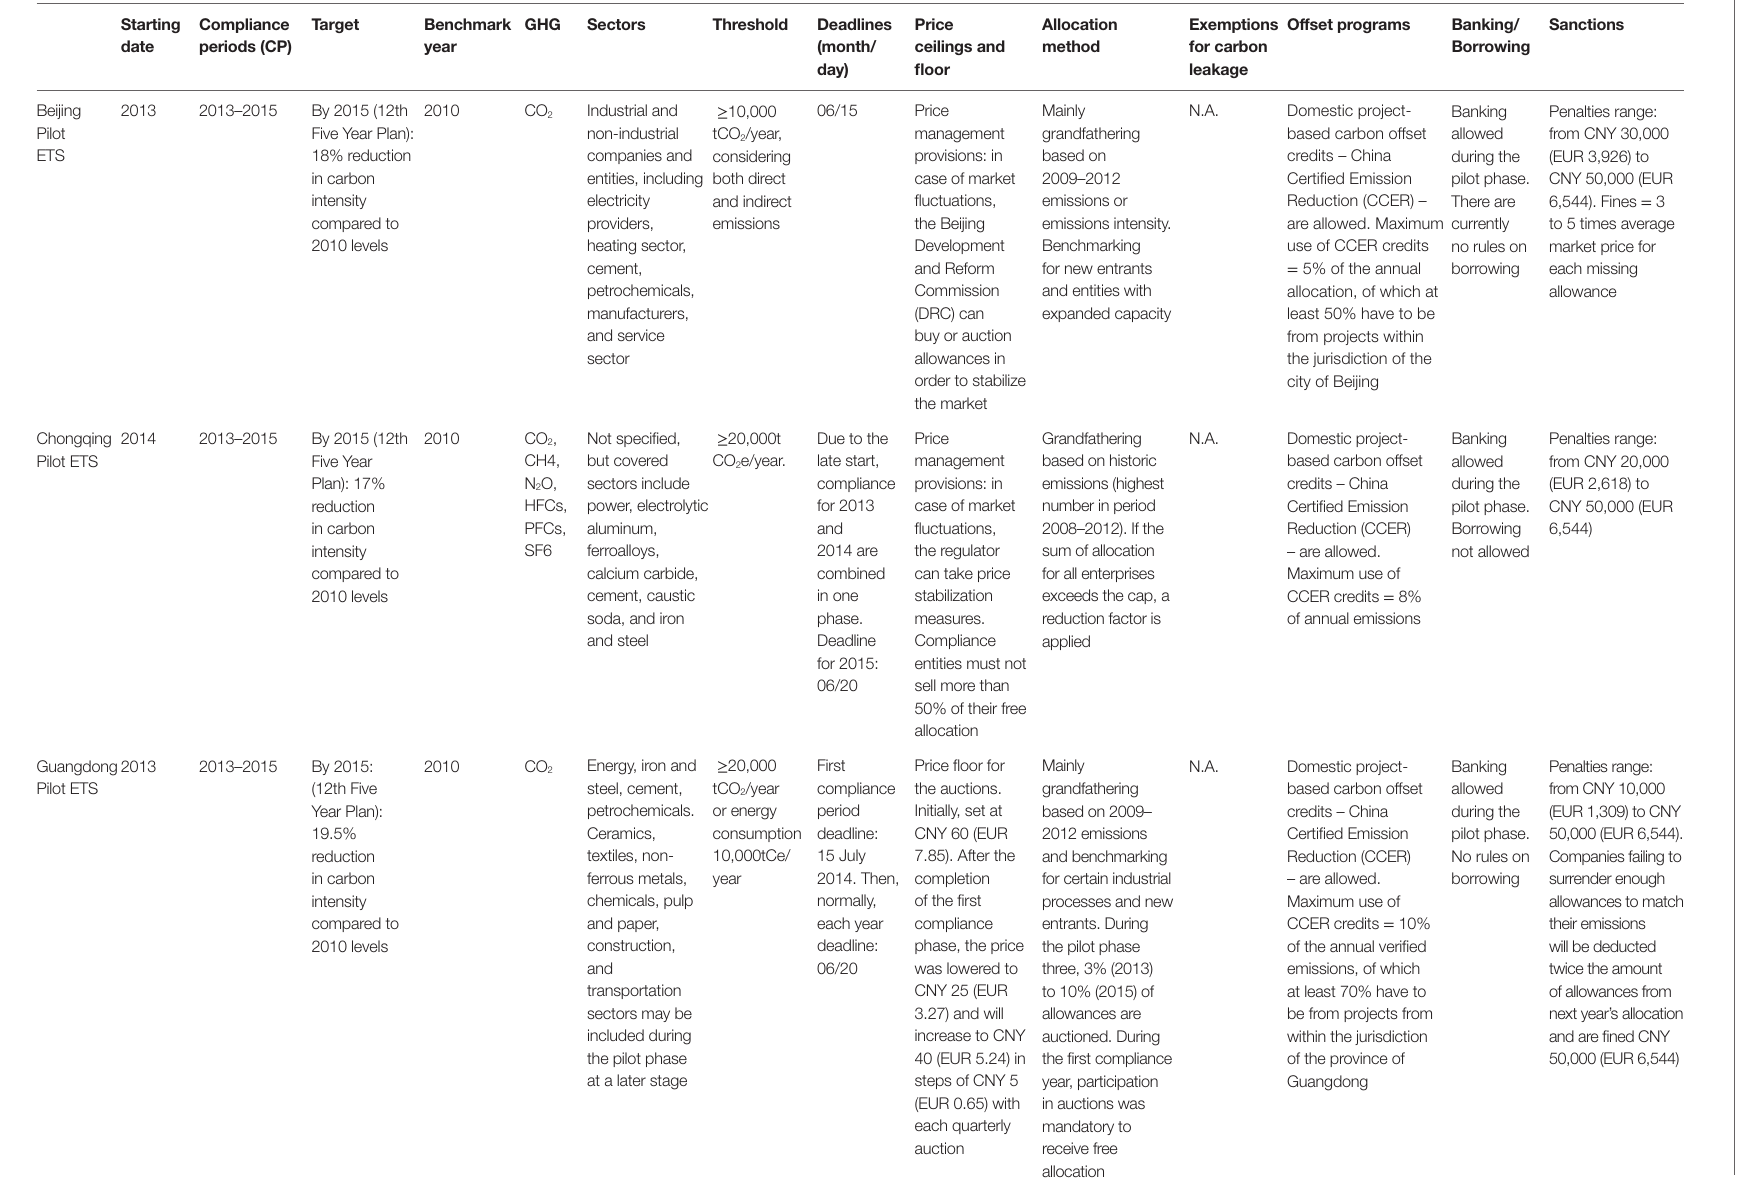
TABLe A1 | The Chinese pilot projects: main features. Starting